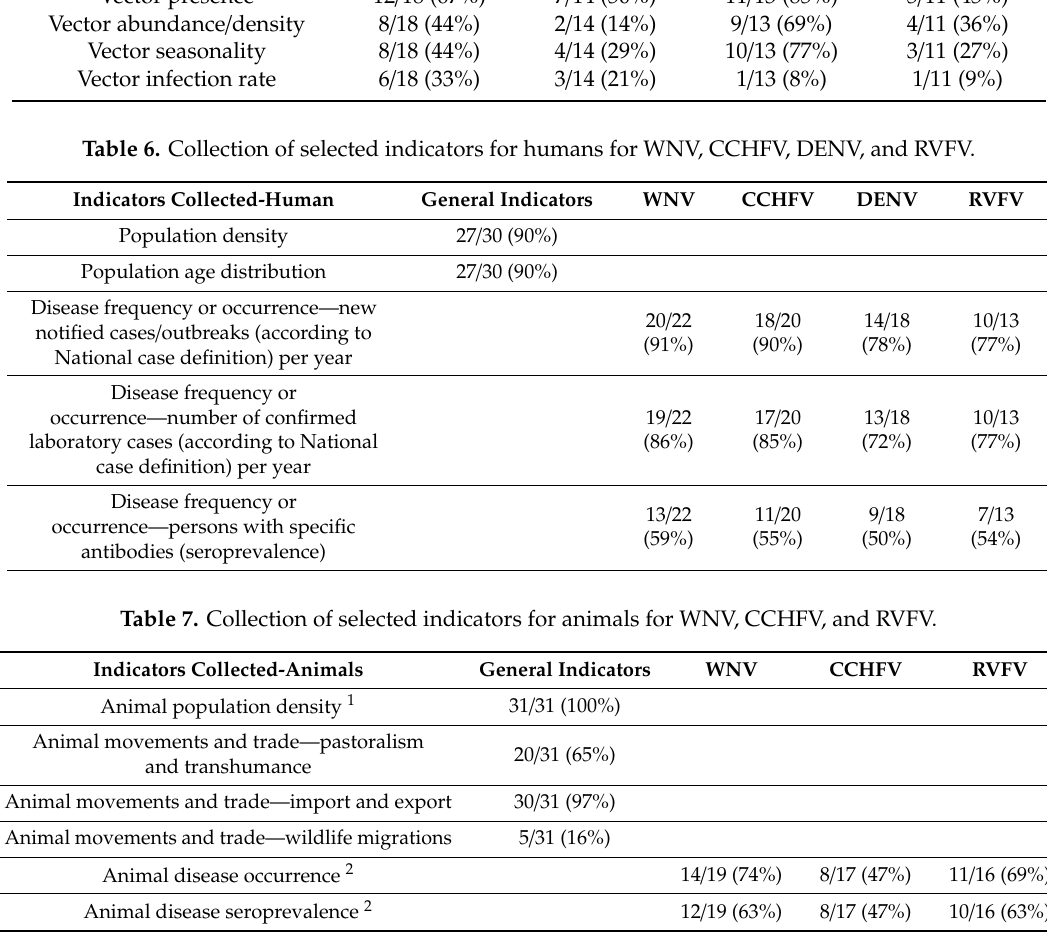
Table 5. Collection of selected indicators for vectors for WNV, CCHFV, Dengue virus (DENV), and RVFV. Indicators Collected-Vector